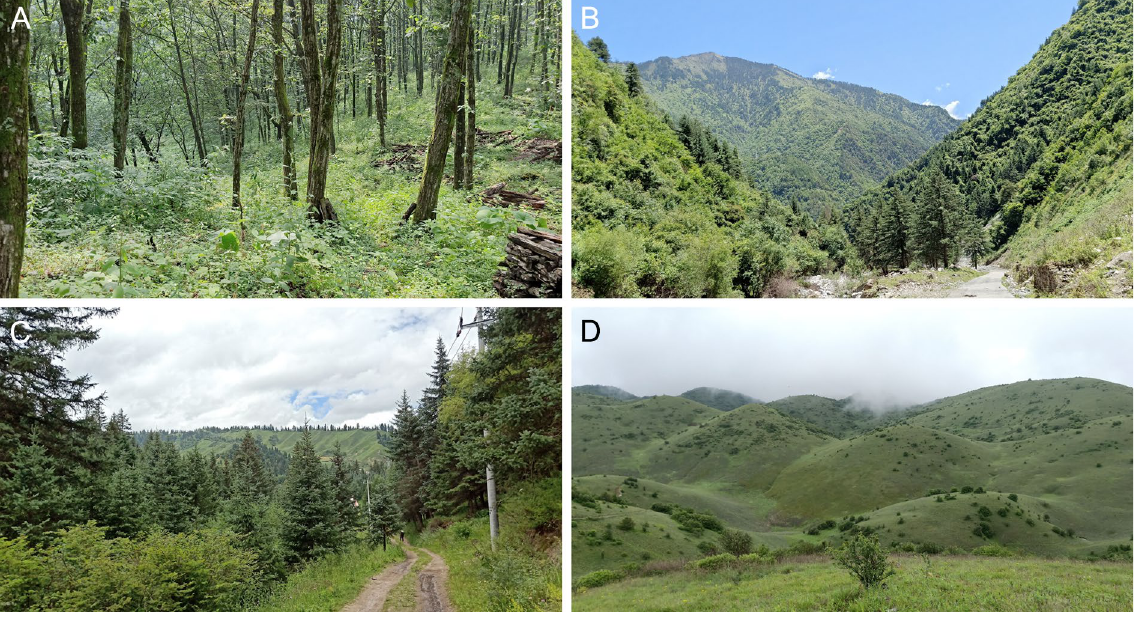
Fig. 3. The habitats of Cerapanorpa Gao, Ma & Hua, 2016. A . Broad-leaf forest in the Bashan Mountains. B . Mixed forest in the Minshan Mountains. C . Coniferous forest in eastern margin of the QTP. D . Alpine shrub meadow in the Bashan